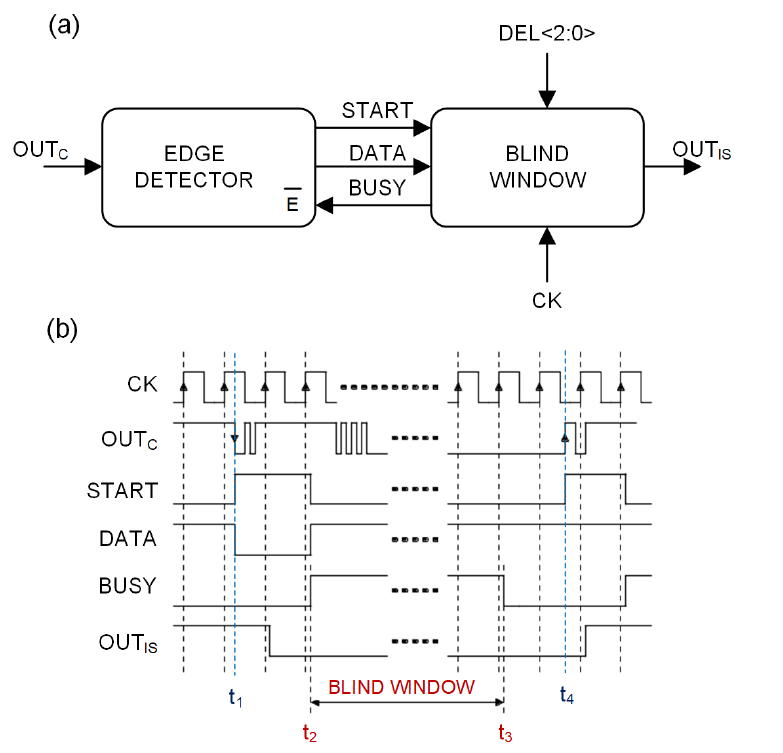
Figure 11. ( a ): Black-box schematic of the digital filter for signals from phonic-wheel sensors. ( b ): Timing